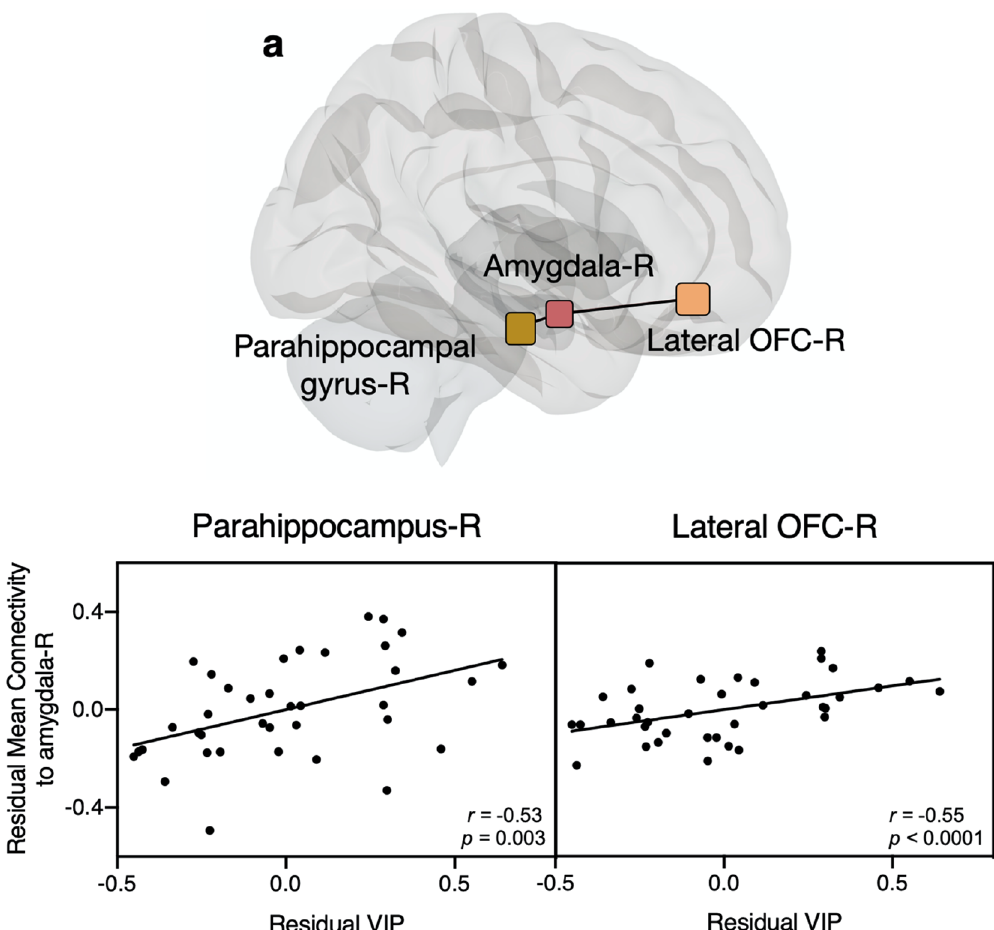
Figure 4. Significant VIP-associated connectivity in resting-state functional MRI. ( a ) Visual representation of regions with significant VIP-associated connectivity within the right hemisphere ( p FDR < 0.02). ( b ) Partial regression plots from bootstrapping showing the relationship between adjusted mean connectivity values and residual VIP values between the right amygdala and either the right parahippocampal gyrus or the right lateral OFC (Pearson’s r and adjusted p -values from bootstrapping). OFC orbitofrontal cortex, VIP vasoactive intestinal polypeptide, R